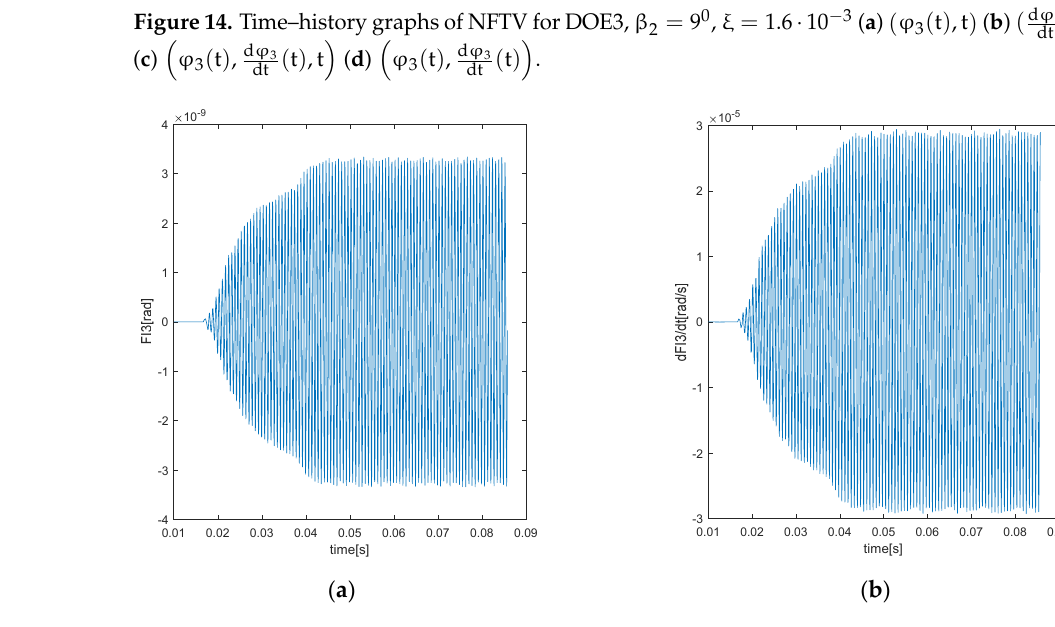
( d ) Figure 15. Time – history graphs of NFTV for DOE3,